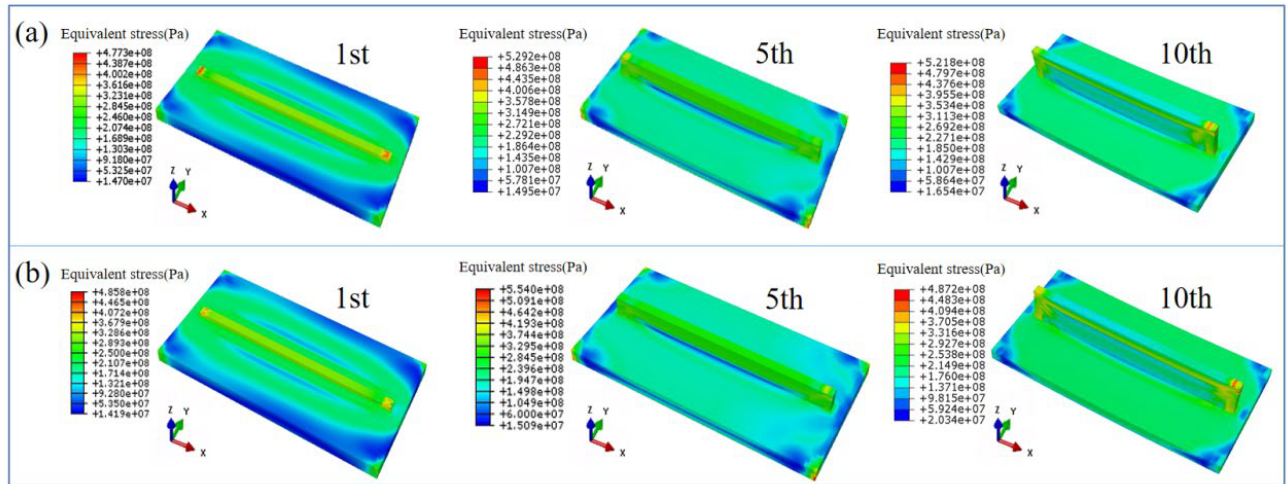
Figure 12. Contour of the equivalent stress distribution for different paths. ( a ) SDM. ( b ) RM.